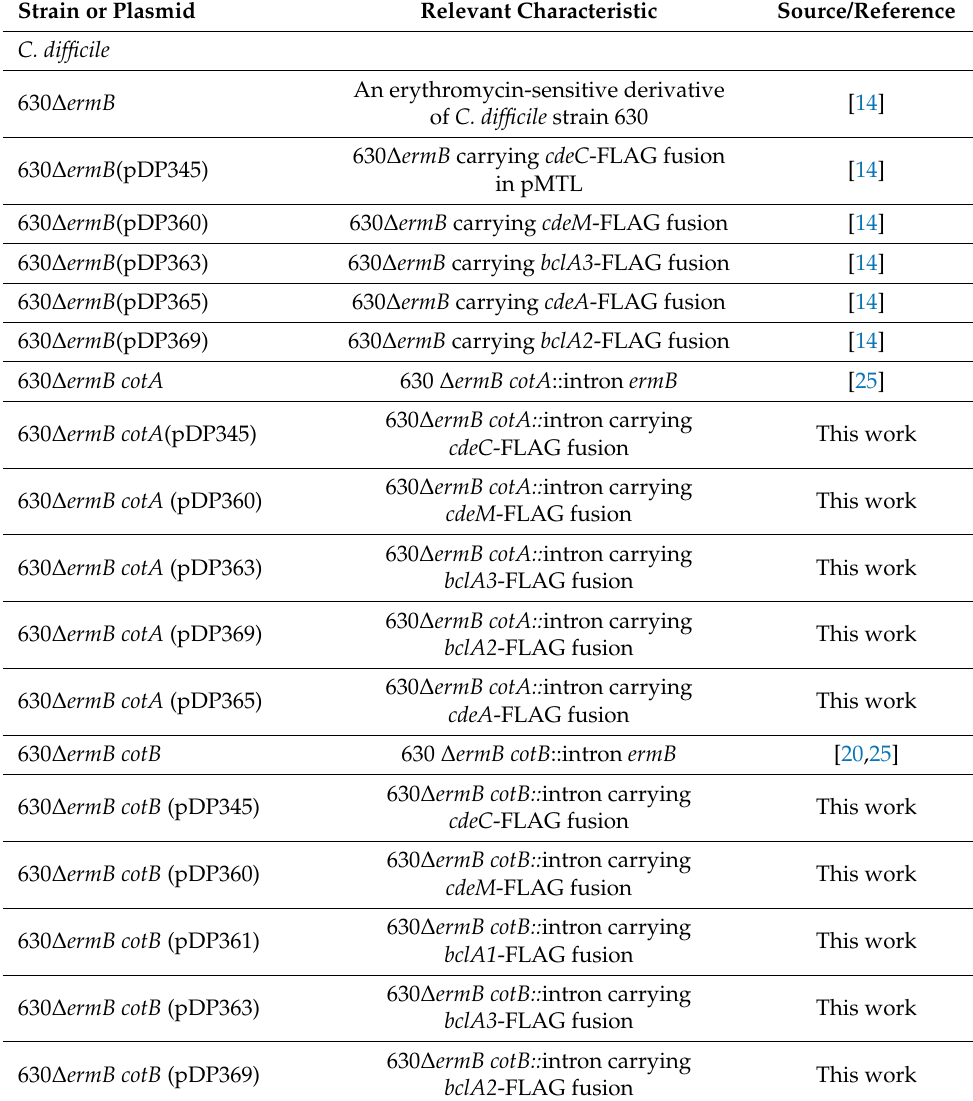
Table 1. Bacterial strains and plasmids